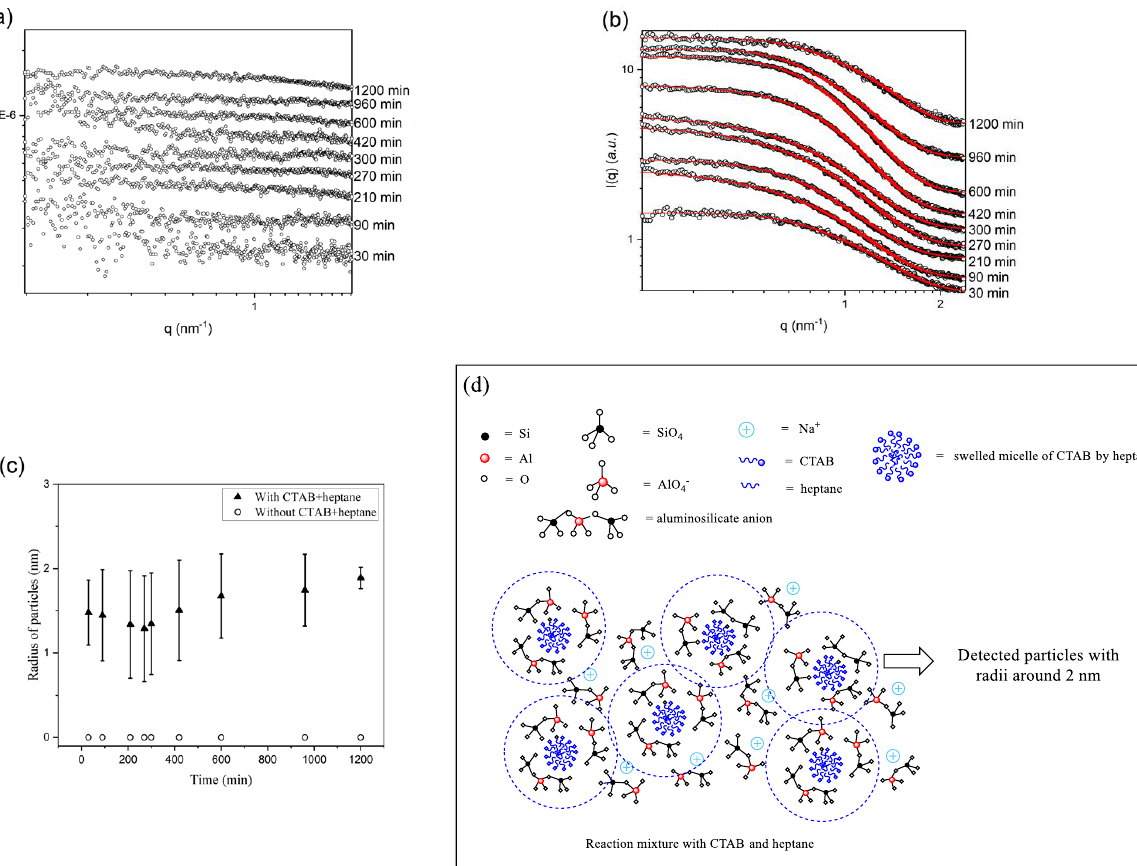
Figure 4. The SAXS profiles of zeolite mixtures at various aging periods at room temperature ( a ) without and ( b ) with additives as shown in spheres and with the fits shown in solid lines. The stack of the curves is for clarity. ( c ) The radii of particles of zeolite mixture without and with additives were obtained from the fits of the scattering curves, and ( d ) the proposed nucleation precursor formation in the presence of CTAB and heptane, which promoted the nucleation precursor.